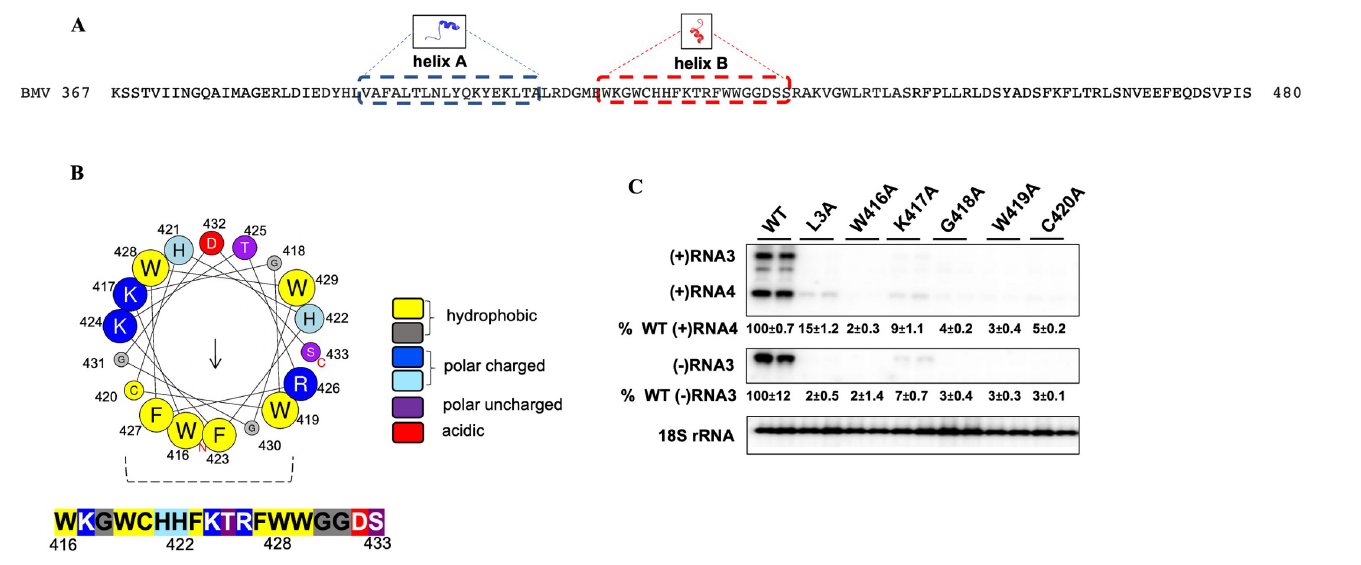
Fig 1. Mutations in BMV 1a helix B inhibit viral genome replication. (A) Helix A and helix B are highlighted in blue and red respectively and their amino acid sequences are shown. Note region E is indicated as a 114 amino acid-long sequence consisting of helix A and helix B. (B) Helical wheel projection generated using an 18 aa analysis window in Heliquest (https://heliquest.ipmc.cnrs.fr/). The predicted hydrophobic face is formed by W419, G430, F423, W416, F427, and C420, as indicated by the dotted lines. The size of each residue in the helical wheel represents the bulkiness of their sidechain and the arrow in the helical wheel corresponds to the hydrophobic moment. (C) BMV genomic replication was measured by using Northern blot for WT and various 1a mutants. Positive- and negative-strand viral RNAs were detected using BMV strand-specific probes. 18S rRNA served as a loading control. Band intensities were measured using Adobe photoshop and the standard deviations are indicated. All experiments were repeated at least three times in duplicates each time. Note: L3A has 3 Leu residues replaced by Ala in helix A and serves as a negative control.